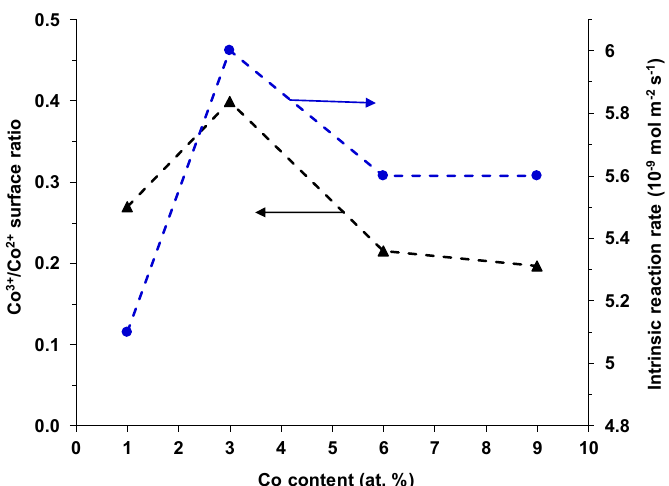
Figure 11. Intrinsic rate of methane conversion measured at 400 °C and Co 3+ /Co 2+ surface atomic ratio as a function of the Co content in the Co(x)CuCeMgAlO catalysts.